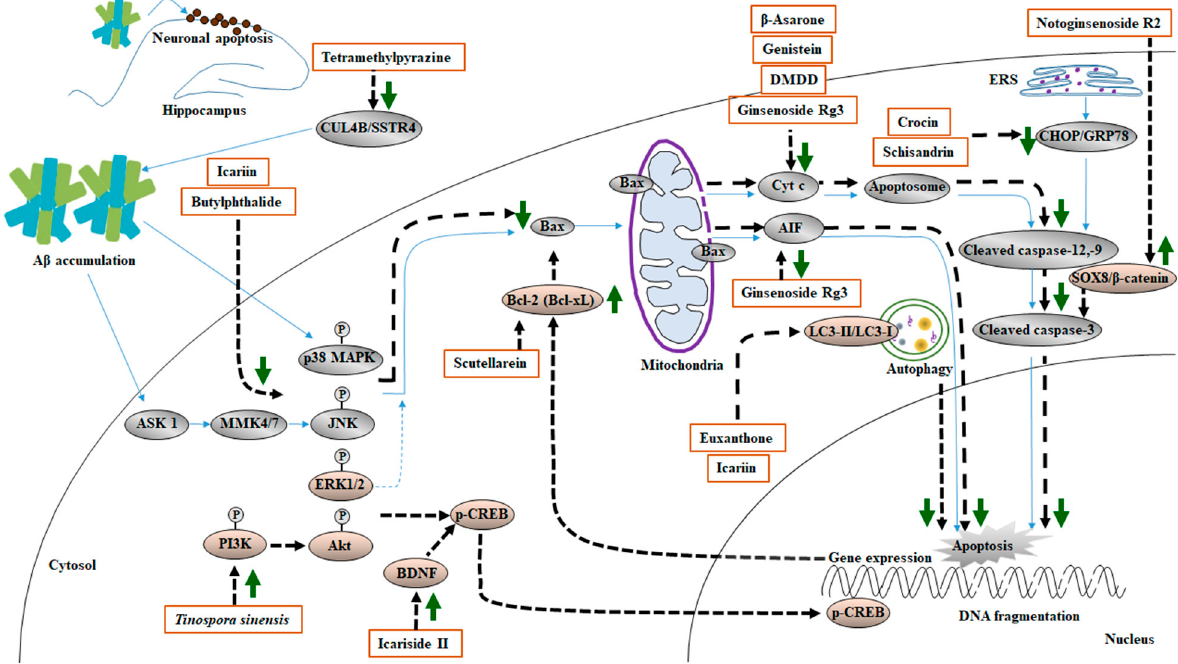
Figure 6. Schematic representation of the effects of MHDIs on A β -induced apoptosis in the cortex and hippocampus in the early and late phases of AD in in vivo models.